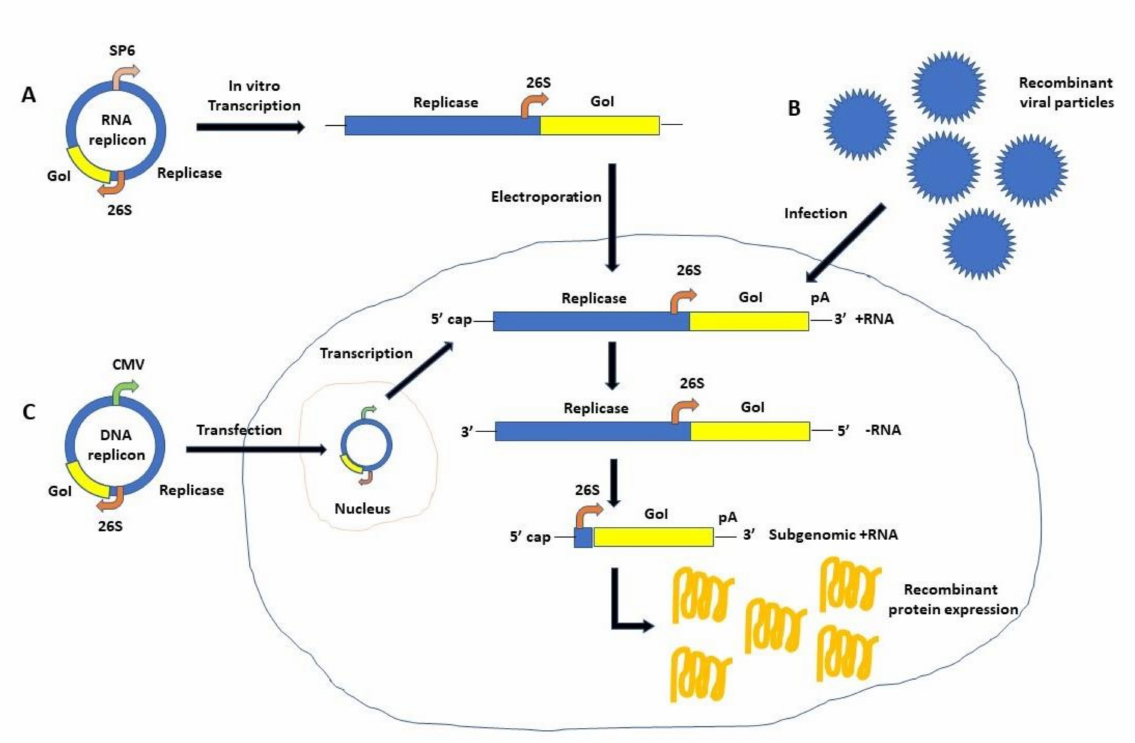
Figure 1. Schematic illustration of self-replicating RNA alphavirus-based expression systems. Alphavirus-based deliv- ery and expression systems comprise of infection of recombinant viral particles, electroporation/lipid-based transfection of in vitro transcribed RNA or transfection of plasmid DNA. Recombinant protein expression can be obtained as follows. In vitro transcribed RNA carrying the replicase gene and the gene of interest is electroporated/transfected into mammalian host cells ( A ). Alternatively, the replicon RNA can be delivered to host cells by infection with recombinant alphavirus particles ( B ). The third option is to transfect alphavirus DNA replicons ( C ), which after DNA delivery to the nucleus RNA is in vivo transcribed. The replicase complex will amplify RNA molecules (self-replication) and recombinant protein will be expressed from the 26S subgenomic promoter. 5 (cid:48) cap, 5 (cid:48) end cap analogue; 26S, alphavirus subgenomic promoter; CMV, cytomegalovirus promoter; GoI, gene of interest; pA, poly A signal; SP6, bacteriophage SP6 RNA polymerase